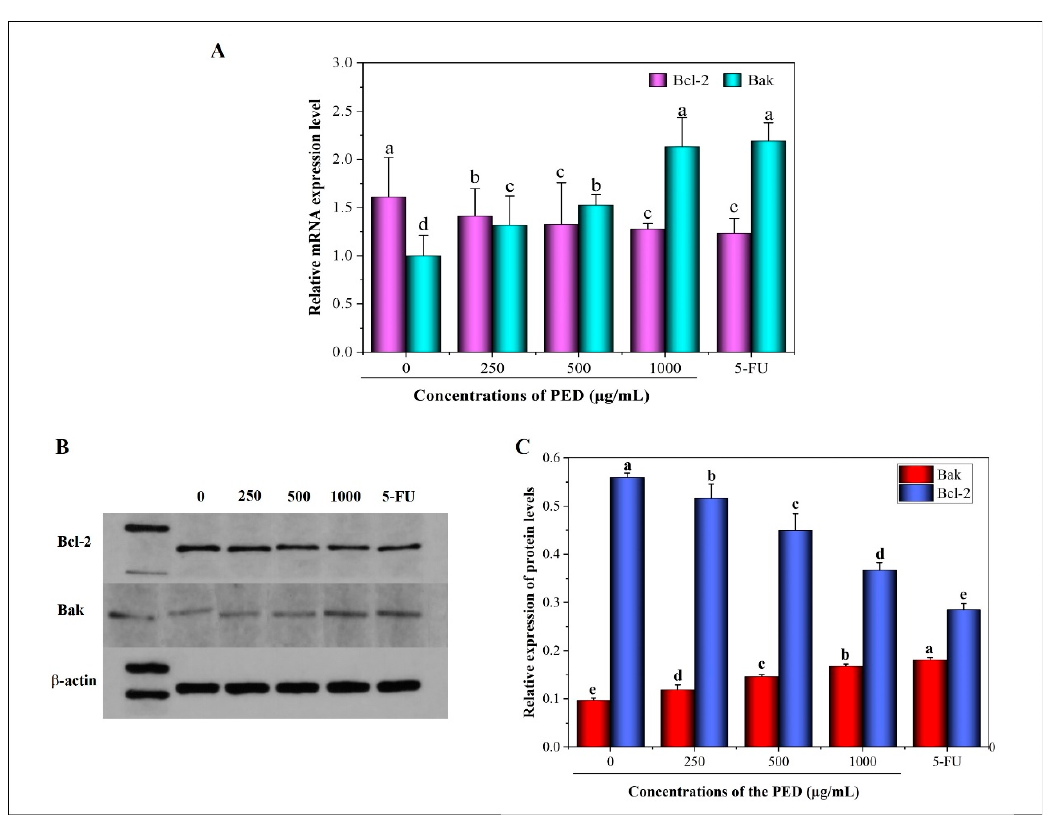
Figure 8. Effect of PED on the expression levels of Bcl-2 and Bak. ( A ): the mRNA expression levels; ( B , C ): the protein expression levels. The β -actin was indicated the internal control. Different lowercase letters indicate significant differences ( p < 0.05).